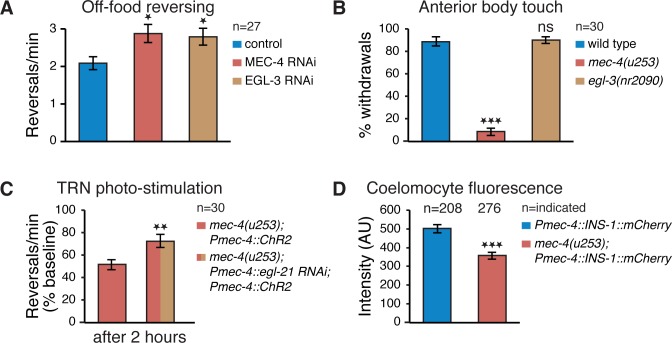
TRN neuropeptide signaling alters the reversing rate of Mec mutants.(A) Off-food reversing rate increases following TRN-specific RNAi silencing of MEC-4 and EGL-3. (B) Percent of withdrawal responses out of five anterior body gentle stimulations of wild type, mec-4 and egl-3 mutants. egl-3 mutants respond similarly to wild type. (C) Suppression of mec-4 off-food elevated reversing rate following TRN optogenetic stimulation is diminished by TRN-specific silencing of EGL-21. (D) Coelomocyte fluorescence of mCherry-tagged insulin-like peptide transgene (INS-1) specifically expressed in the TRNs is decreased in mec-4 mutants. Sample size indicated in each panel; Error bars represent SEMs; *p < 0.05, ***p < 0.001 t test with Bonferroni corrections for multiple comparisons where relevant.